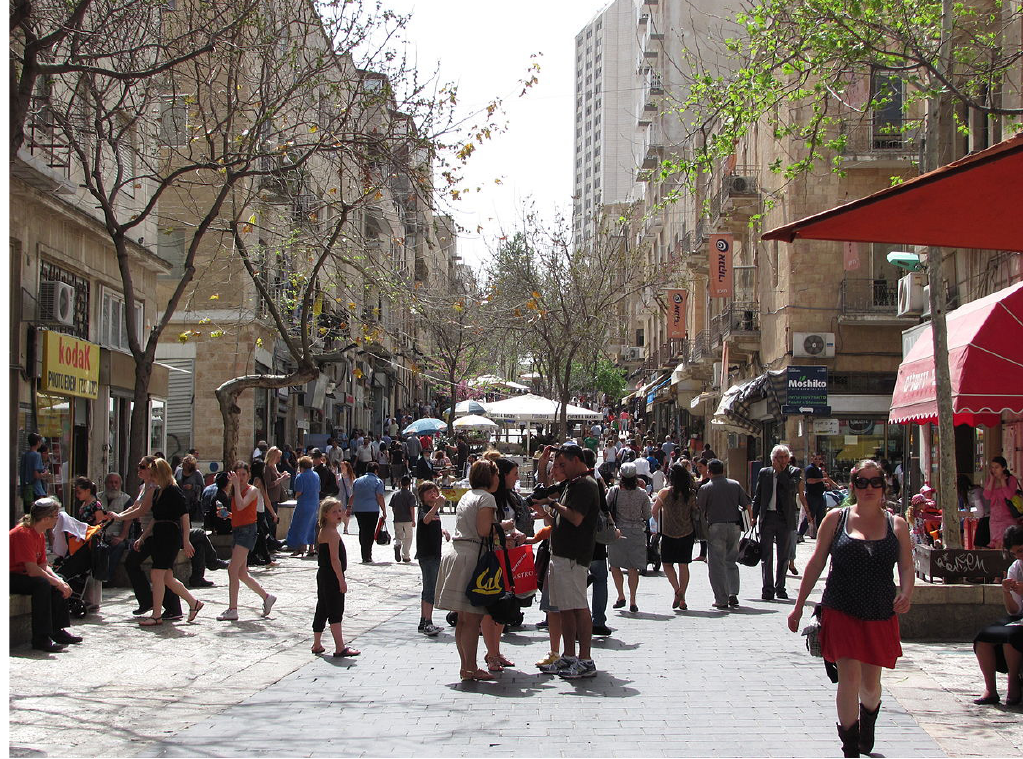
Figure 9. Ben Yehuda Street Pedestrian Mall, Jerusalem, serving as the theme photo of the Facebook group Renewing Urbanity in Israel. Source: Yoninah